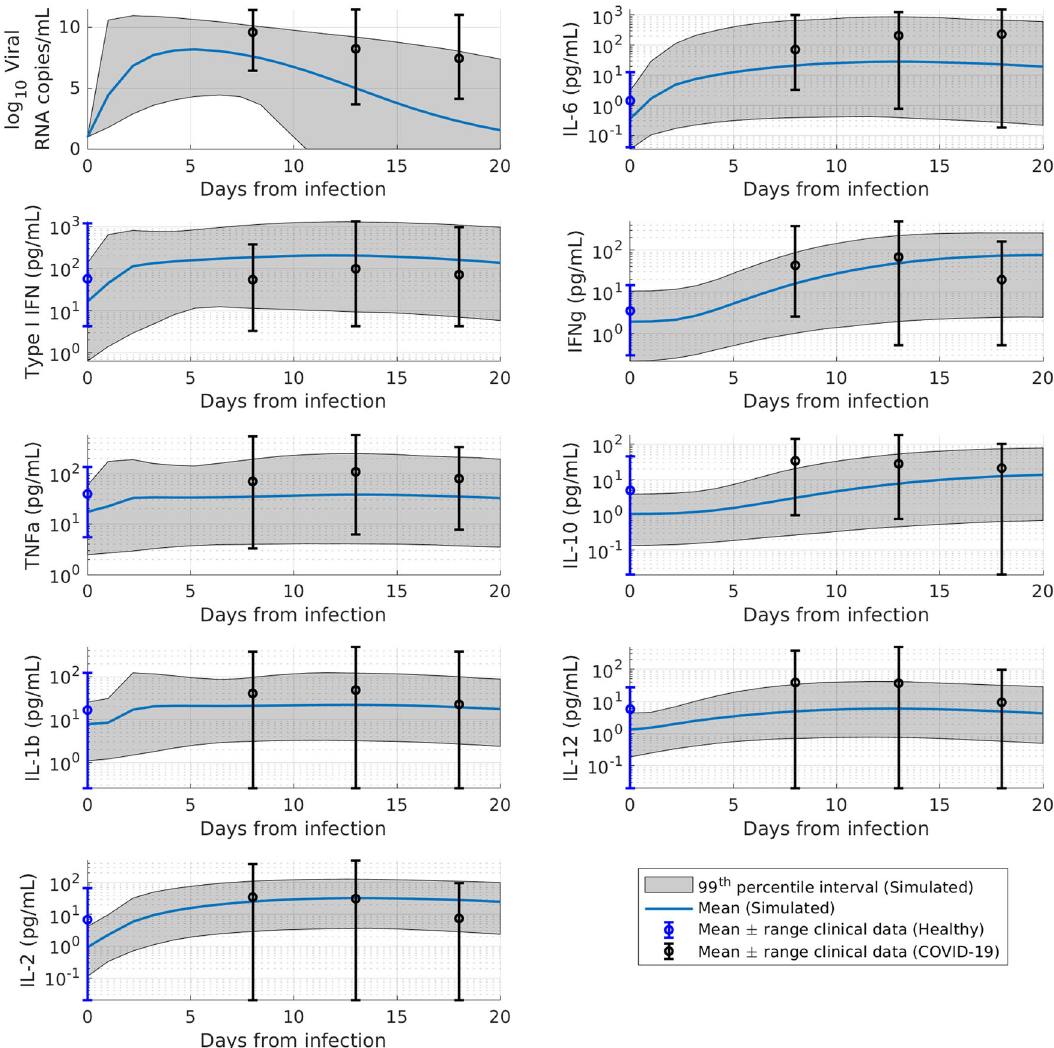
Fig. 2 Time course of plausible population model states compared against observational COVID-19 clinical data for viral load and representative cytokines. Plausible population overlaid against observational COVID-19 clinical data for the viral load time course and different representative cytokines ( N = 14,545). For the purpose of visual representation of the time course of the viral and immune makers from the day of infection, the time from symptom onset was translated to a time from infection by assuming an incubation period of 4.5 days based on the mean incubation period for SARS-CoV-2 estimated 35 . Subsequently, the data are binned across 5-day intervals [0 – 5 d, 5 – 10 d, 15 – 20 days post infection] for visual representation. Data extracted from studies listed in Supplementary Table